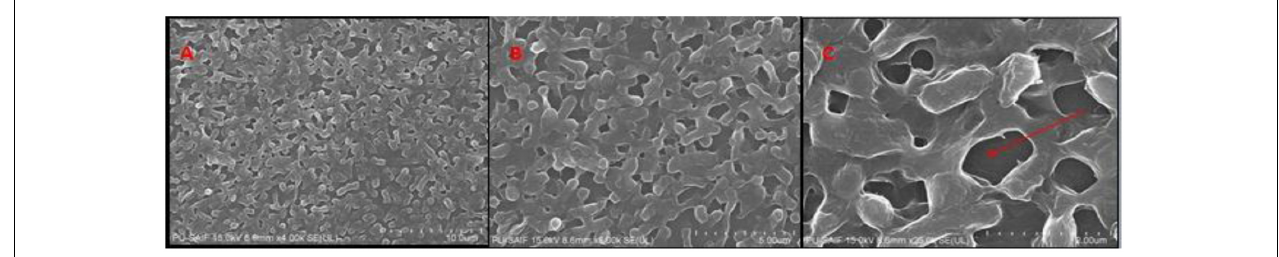
Figure 2 . A gradual increase in OD 595 of K. pneumoniae was seen till fifth day, followed by decrease thereafter. The result of crystal violet staining (semi-quantitative estimation) confirmed the results of plate count method. On day 1, initial counts of 7.4 logs increased to 8.16 logs on fifth day. After fifth day, a gradual decrease in biofilm count was observed and 7.21 logs bacterial count was observed on seventh day.